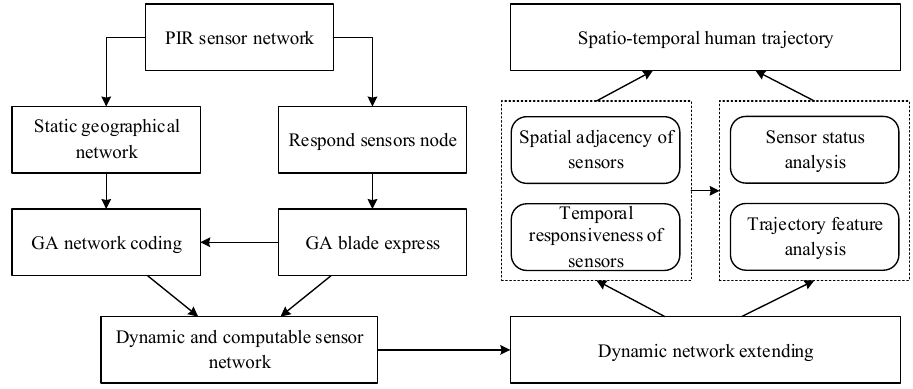
Figure 4. Basic idea.